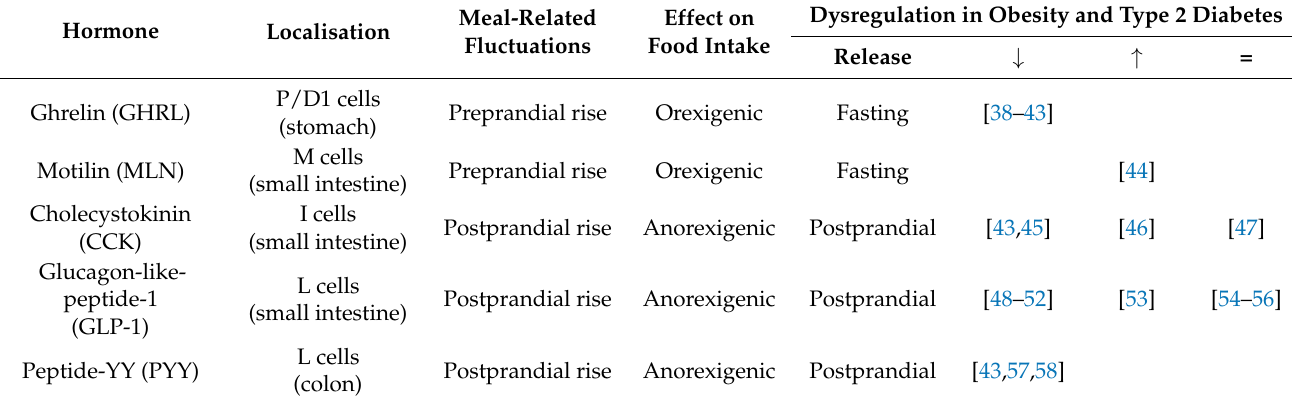
Table 1. An overview of the meal-related fluctuations in gut hormone levels and their alterations in obesity and type 2 diabetes